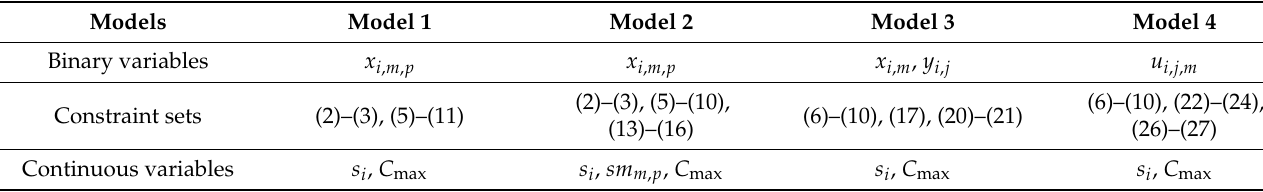
Table 1. Summary of four MILP Models.